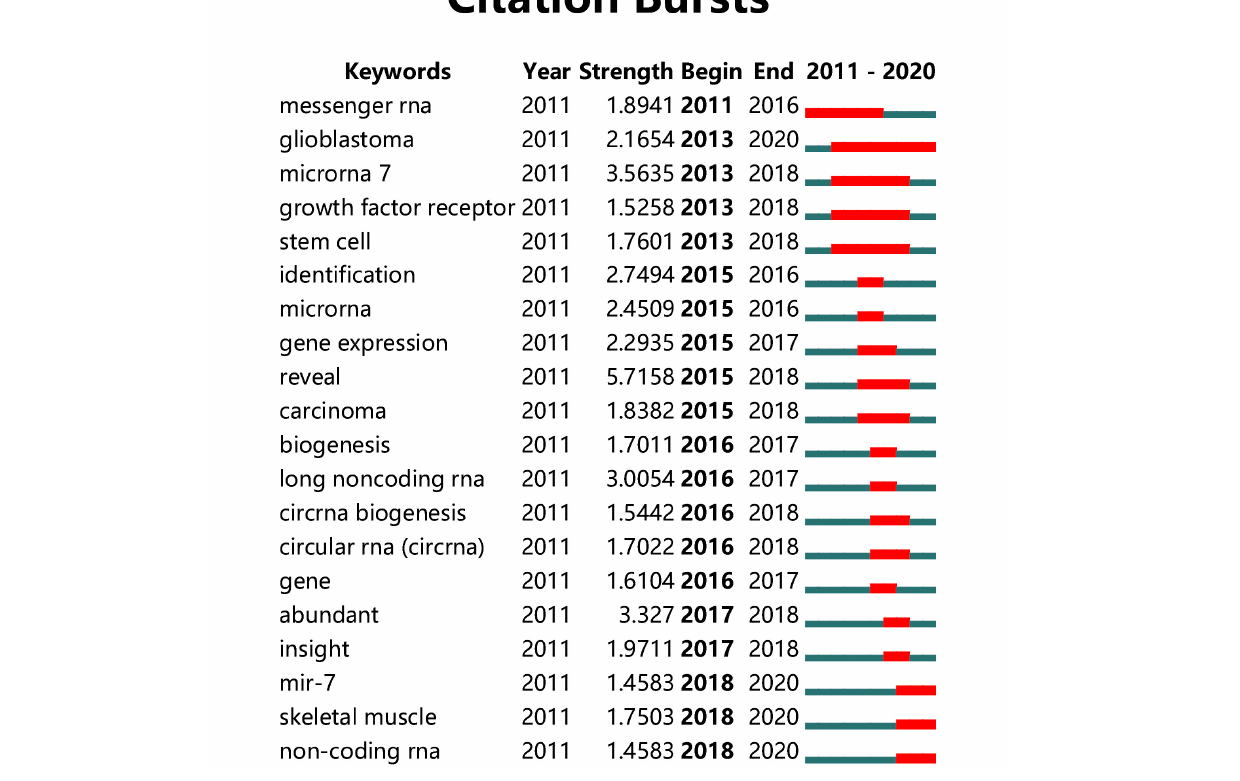
FIGURE 5 | The top 20 keywords with the strongest citation bursts of publications on the crosstalk between microRNAs and circular RNAs.